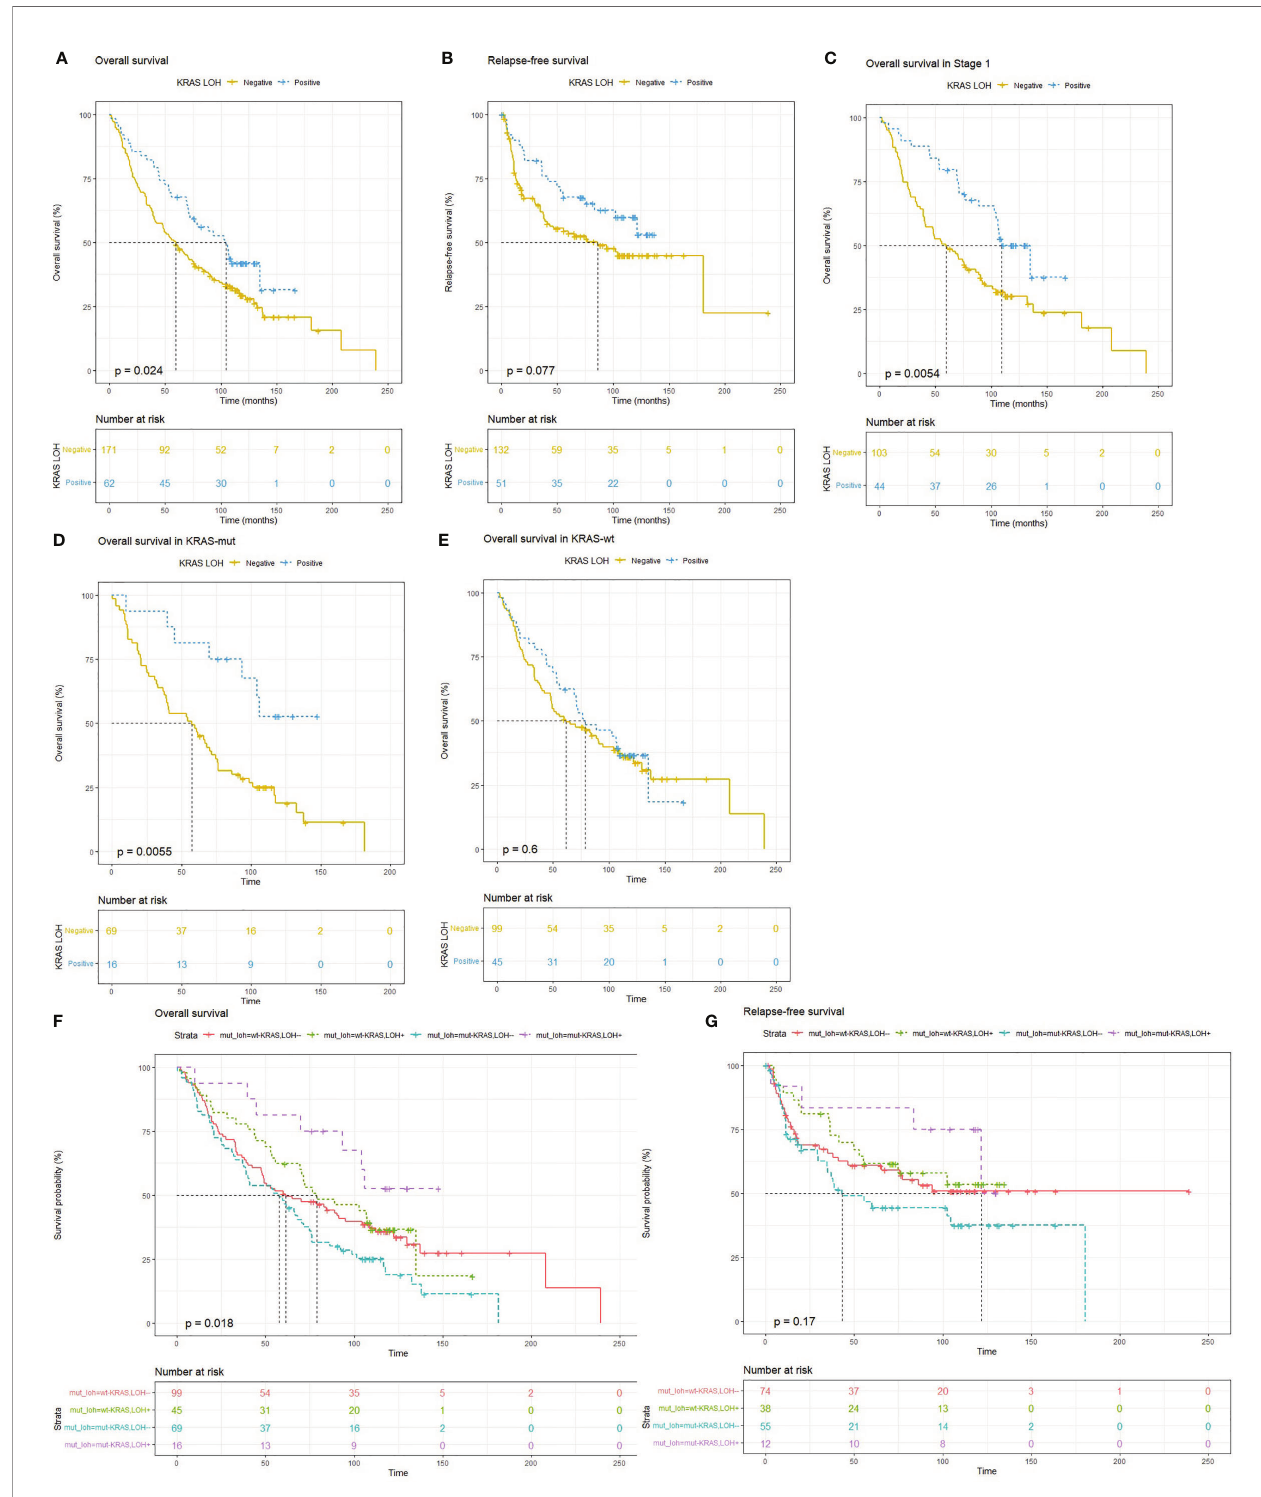
FIGURE 2 | Kaplan – Meier survival plots for (A) overall survival (OS) and (B) relapse-free survival (RFS) in patients with lung adenocarcinomas with and without LOH in KRAS indicating improved survival with LOH in KRAS . (C) OS in patients with stage I disease. (D) OS in wild-type KRAS tumors and (E) KRAS mutated tumors. (F, G) OS and RFS in patients based on combined KRAS mutation and LOH status, where patients with both KRAS mutation and KRAS LOH (purple) have better OS and RFS, whereas patients with only KRAS mutation and no KRAS LOH (blue) have the worst OS as well as